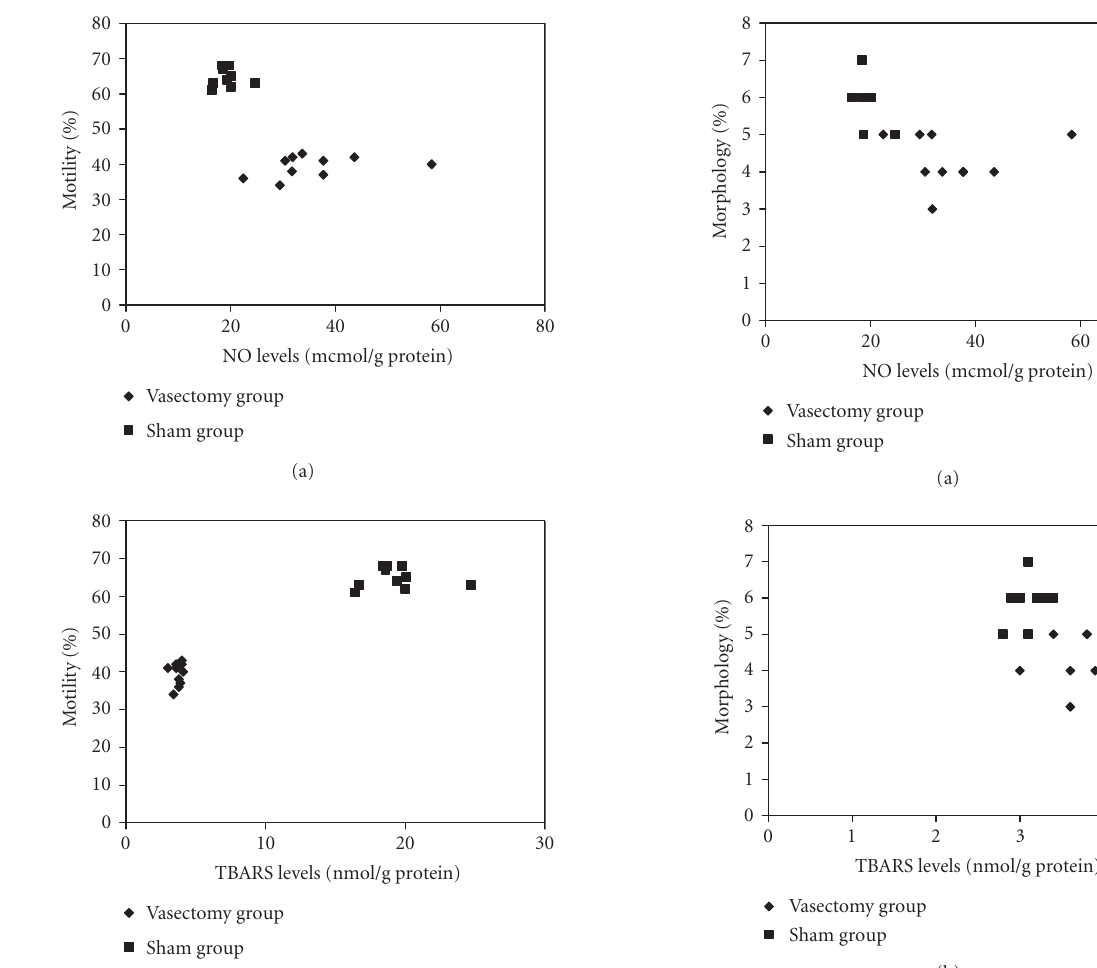
Burns JR. Pregnancy outcomes after vasectomy reversal for fe- male partners 35 years old or older. The Journal of